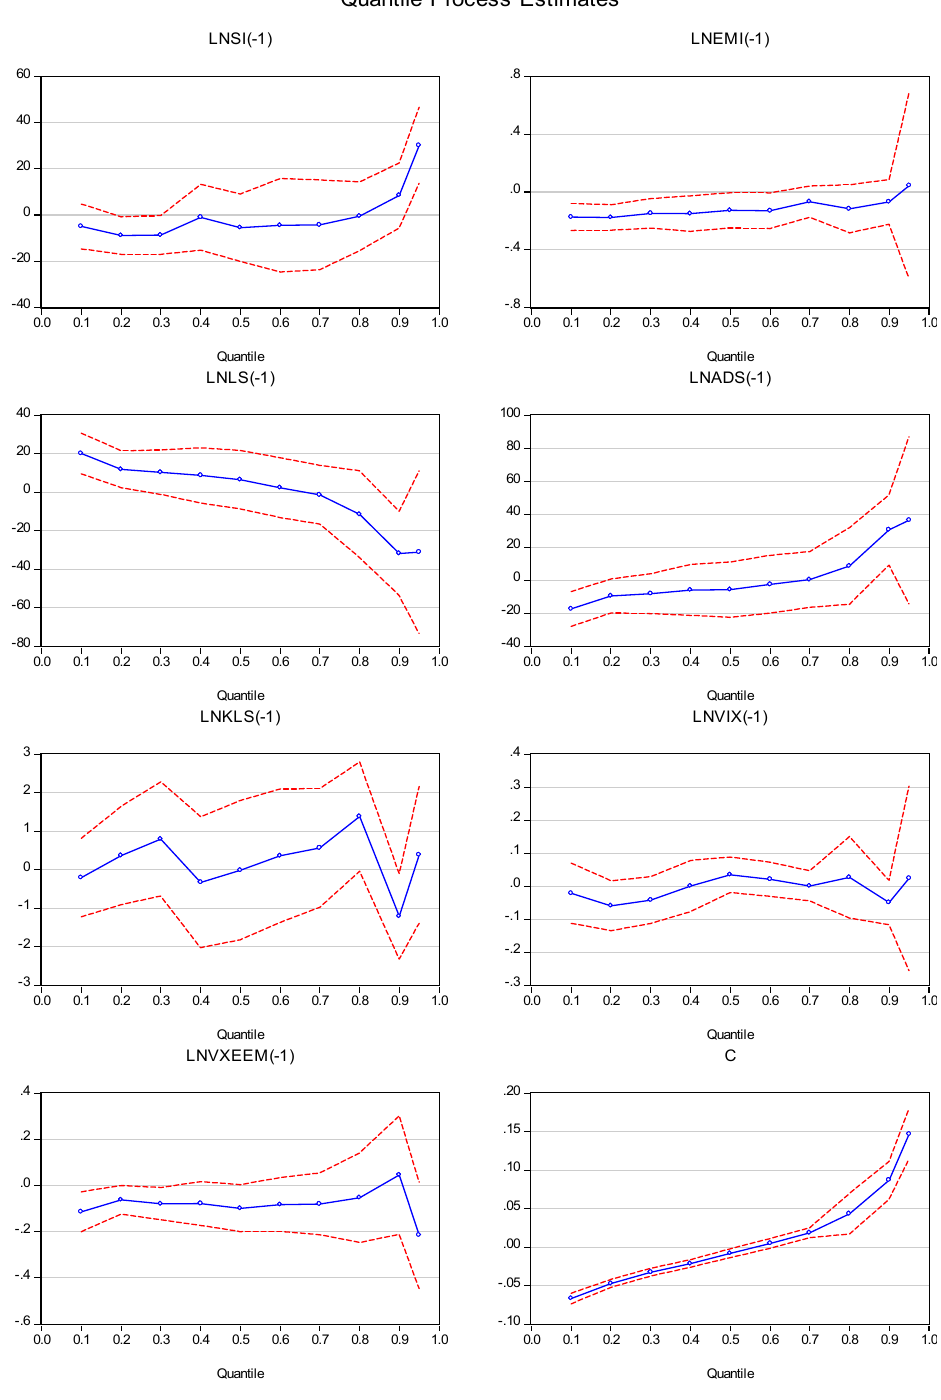
Figure 4. Quantile Process Estimates based upon results of Table 2. As far as financial uncertainty factors are concerned, the Sukuk index negatively re- lates to (VXEEM) volatility indicator for emerging markets. No significant response to- wards the sharp moments was found in the markets too. This is also true for the London Sukuk bond lagged quartile values. The study provides a comprehensive analysis to con- firm the correlation between the Sukuk index, emerging market and financial uncertainty factors. It is observed that there is an indication of the negative causal effect of London Sukuk bond prices and the financial uncertainty factor, that is, the VXEEM volatility index on the Islamic Sharia Index. In terms of an initial co-moment perspective, the relationship